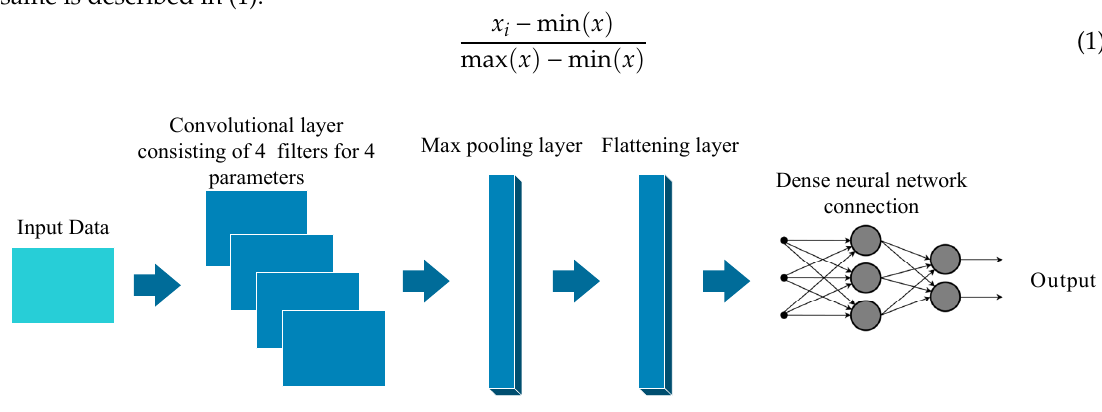
Figure 1. Convolutional Neural Network (CNN) structure.